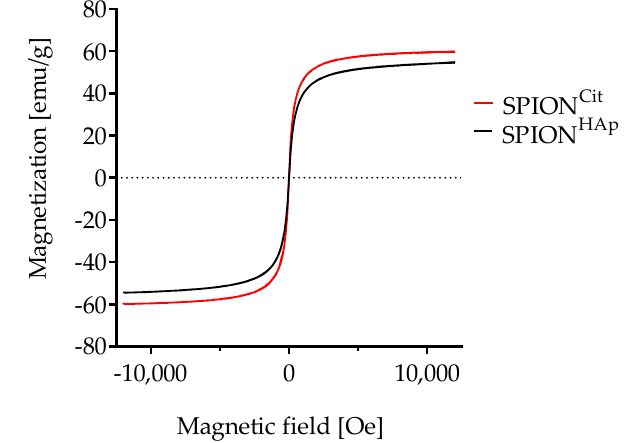
Figure 4. Magnetization curves of SPION Cit and SPION HAp .